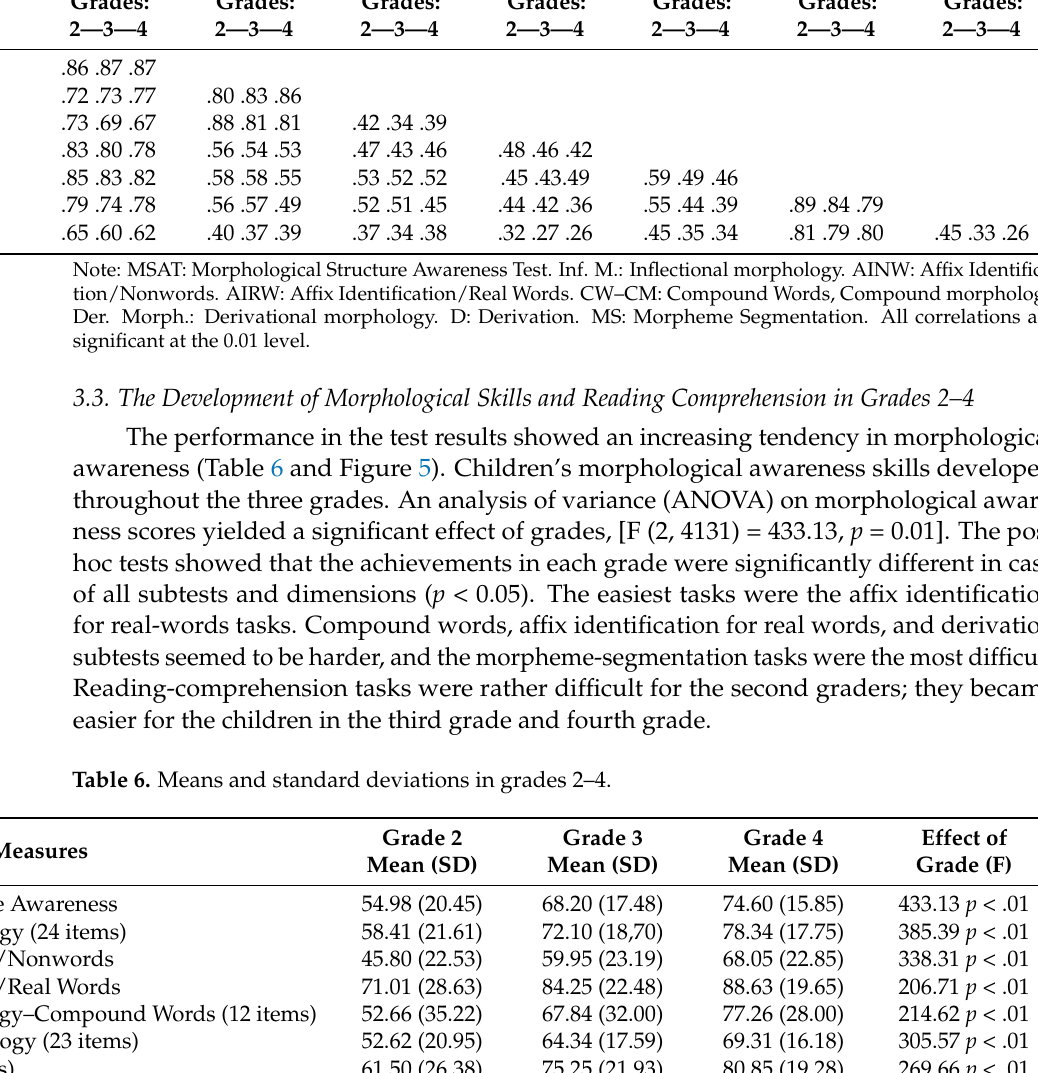
(e.g., dotted lines correspond to inflectional morphology). The different skills develop in